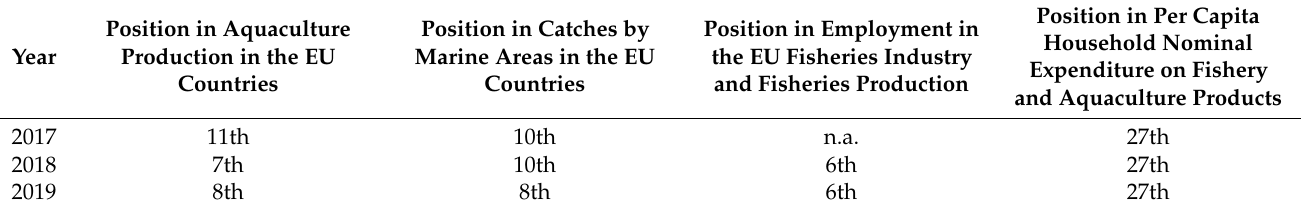
Table 1. Position of Poland in the EU rankings in different categories regarding aquaculture produc- tion, catches by marine areas fish processing, employment in the EU fisheries industry and fisheries production, and per capita household nominal expenditure on fishery and aquaculture products (source: EUMOFA [123,138–140] based on Eurostat